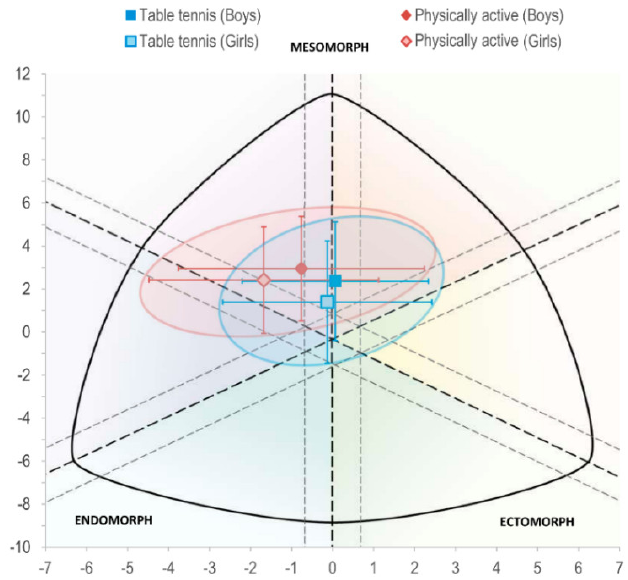
Figure 2. Somatochart of boys and girls aged 10–11 years who regularly practice table tennis against those who are physically active but not engaged in a regular activity. Error bars are standard deviations.